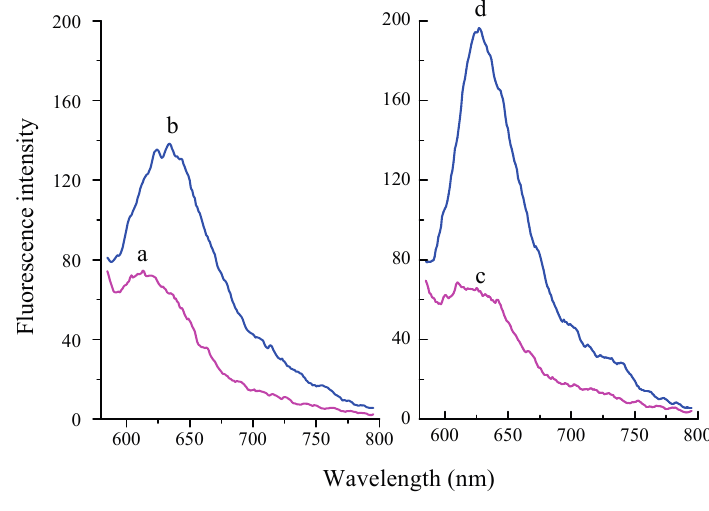
Figure 2. Fluorescence spectra of ( a ) GO + probe 1; ( b ) GO + probe 1 + T-DNA; ( c ) GO + probe 2; ( d ) GO + probe 2 + T-DNA.